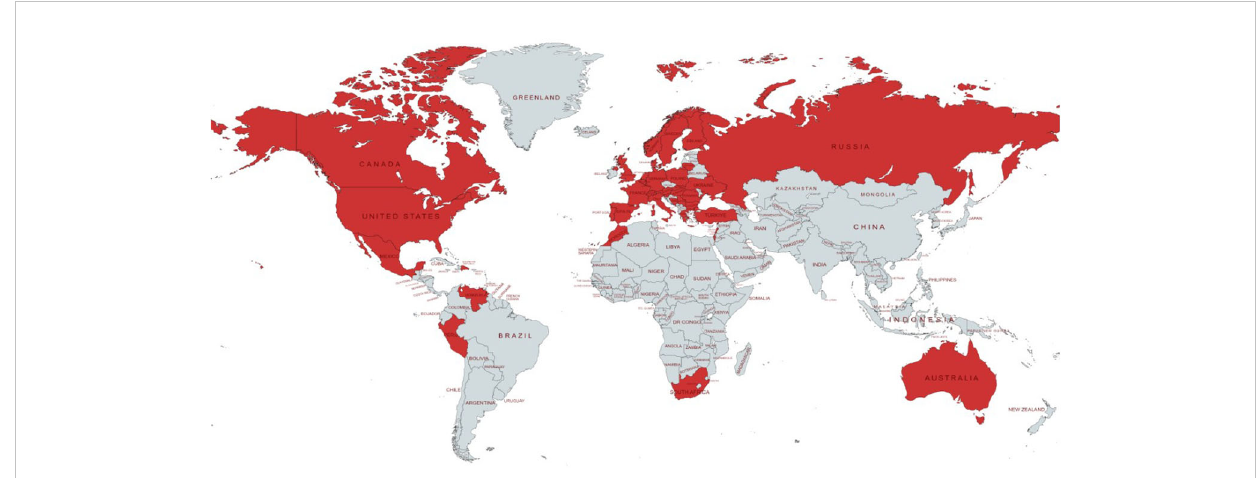
FIGURE 1 Geographical distribution of countries represented in the dataset. Each country with at least one patient with PID responding to the survey is colored in